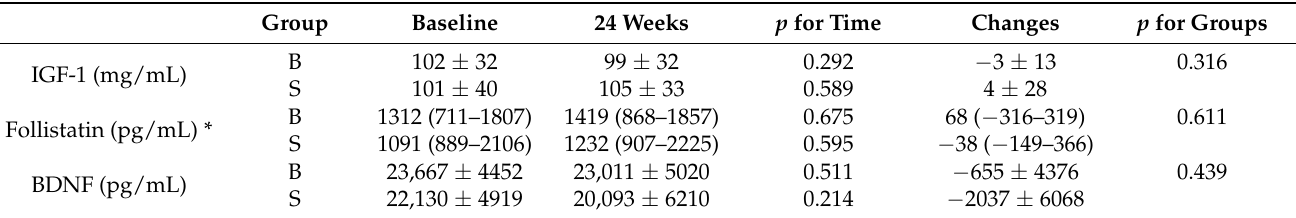
Table 5. Changes in serum levels of insulin-like growth factor 1, follistatin, and brain-derived neurotropic factor during the